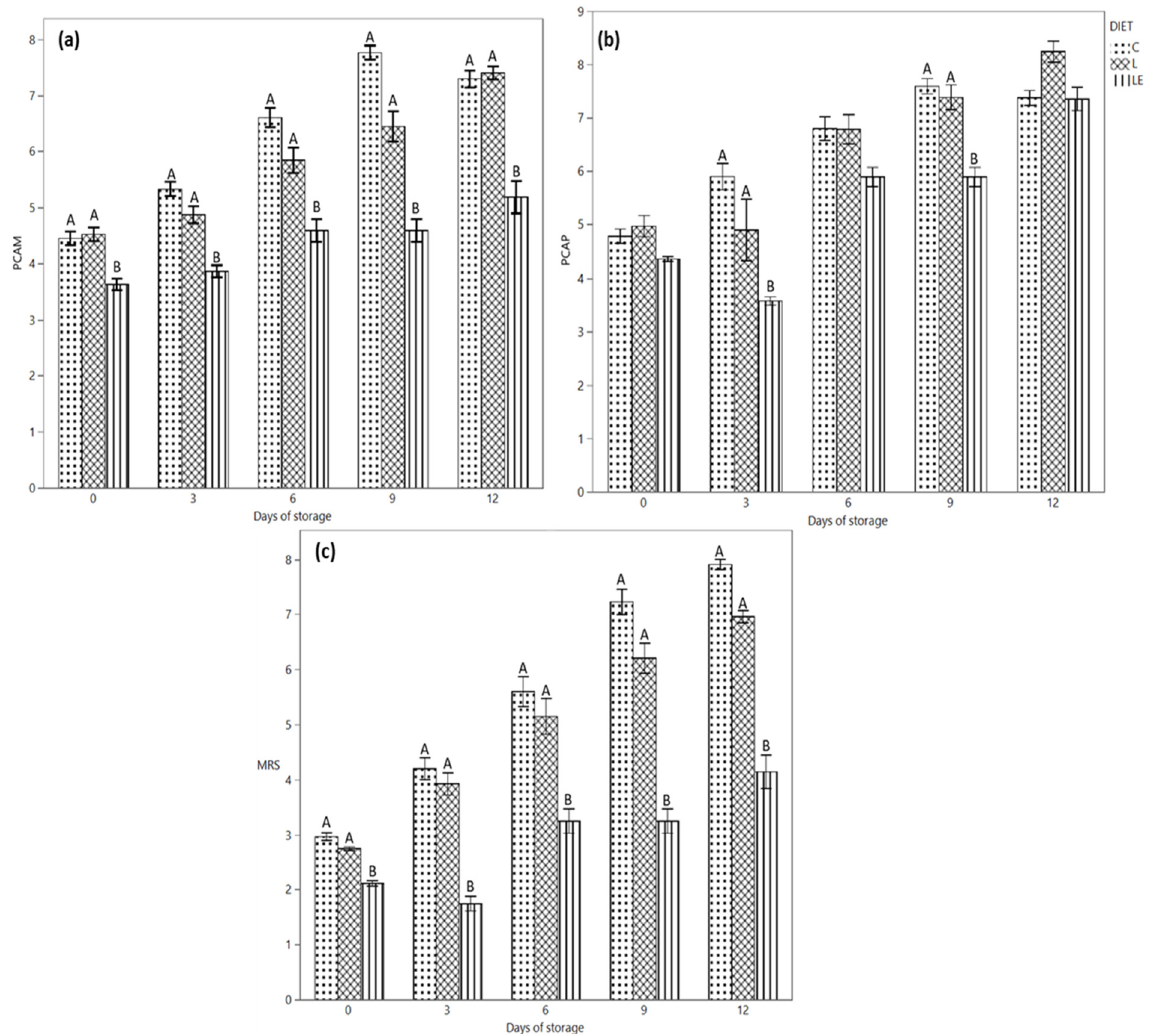
Figure 3. ( a ) Evolution of the mesophilic aerobic population, ( b ) psychrotrophic aerobic population and ( c ) lactic acid bacteria during the refrigerated storage of Marchigiana beef burgers in a modified atmosphere packaging. C = Control; L = Linseed; LE = Linseed plus vitamin E. Different letters indicate significant differences (A, B: p < 0.01) within each time point.